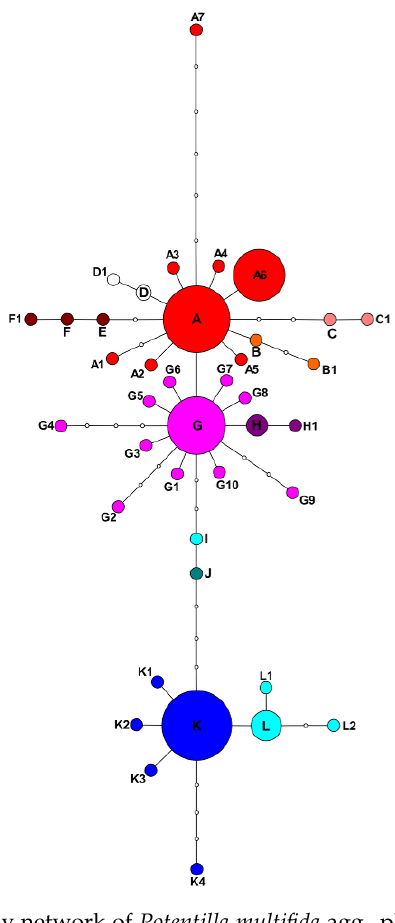
Figure 2. Statistical parsimony network of Potentilla multifida agg. plastid haplotypes. Bold letters designate internal haplotypes, letters and numbers designate tip haplotypes derived from corresponding internal ones. Colors distinguish haplotype lineages. Small empty circles indicate missing hypothetical haplotypes deduced by the program. Each edge corresponds to one mutational step.